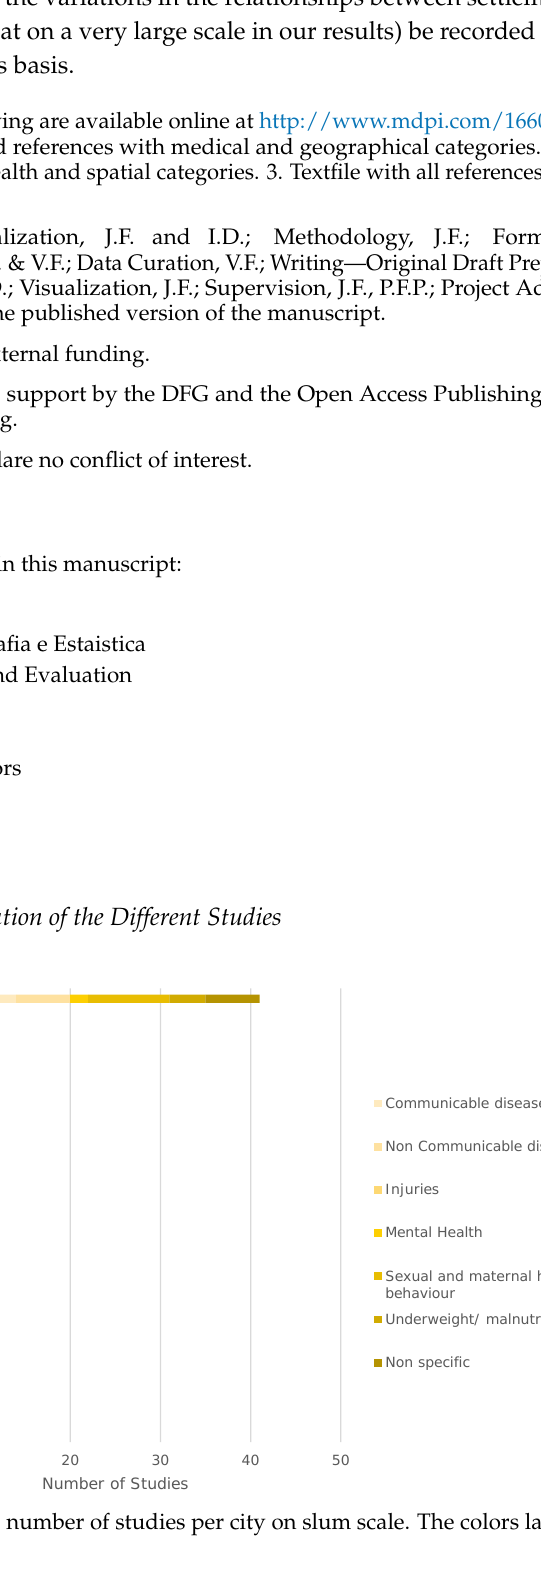
Table S1: All references classified by health and spatial categories. 3. Textfile with all references and related .bibtex information.